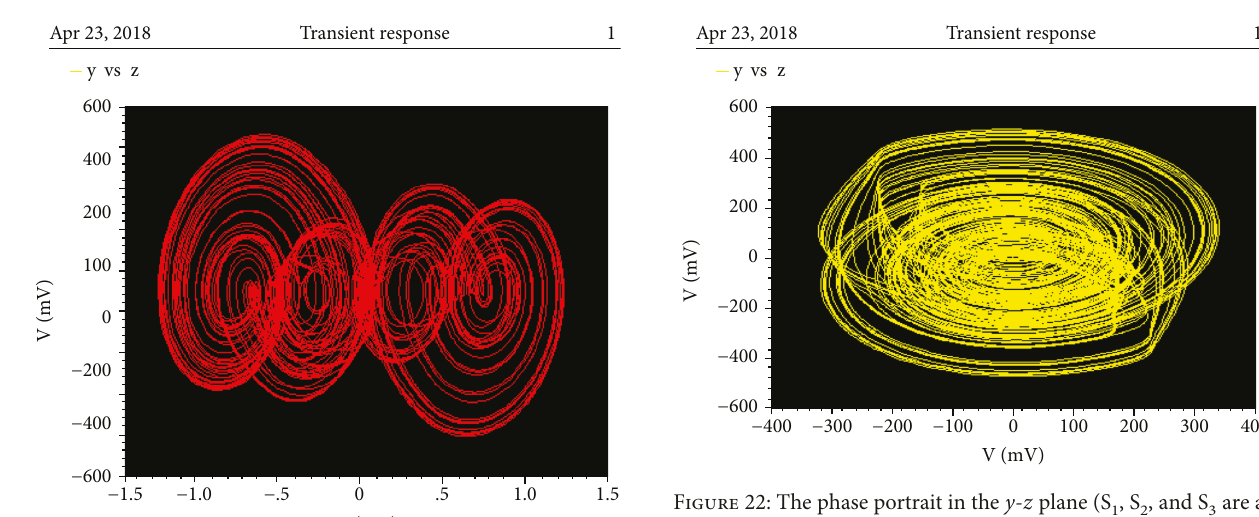
, S , and S are all 1 2 3